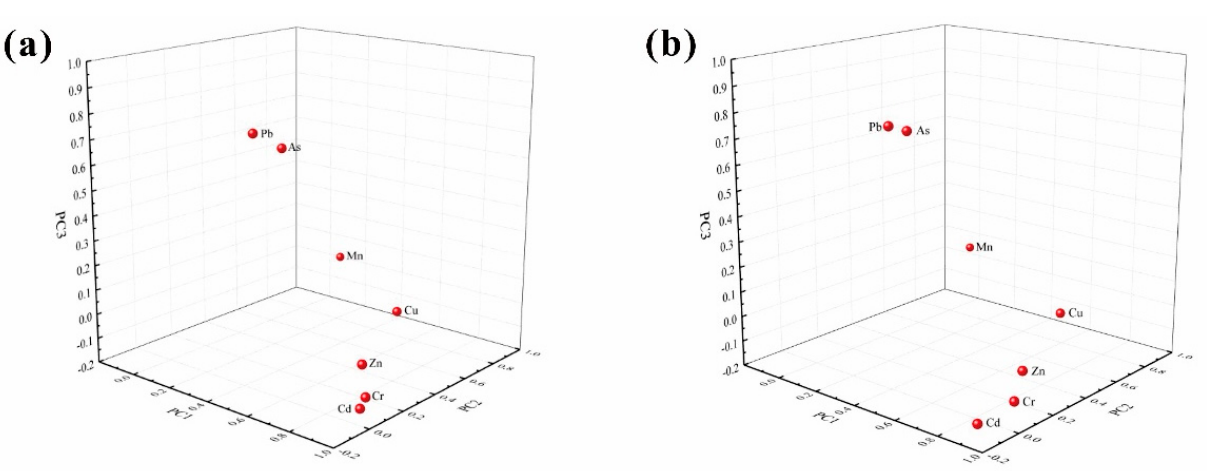
Figure 4. Factor analysis of PTEs in the river waters ( a ) and sediments ( b ).